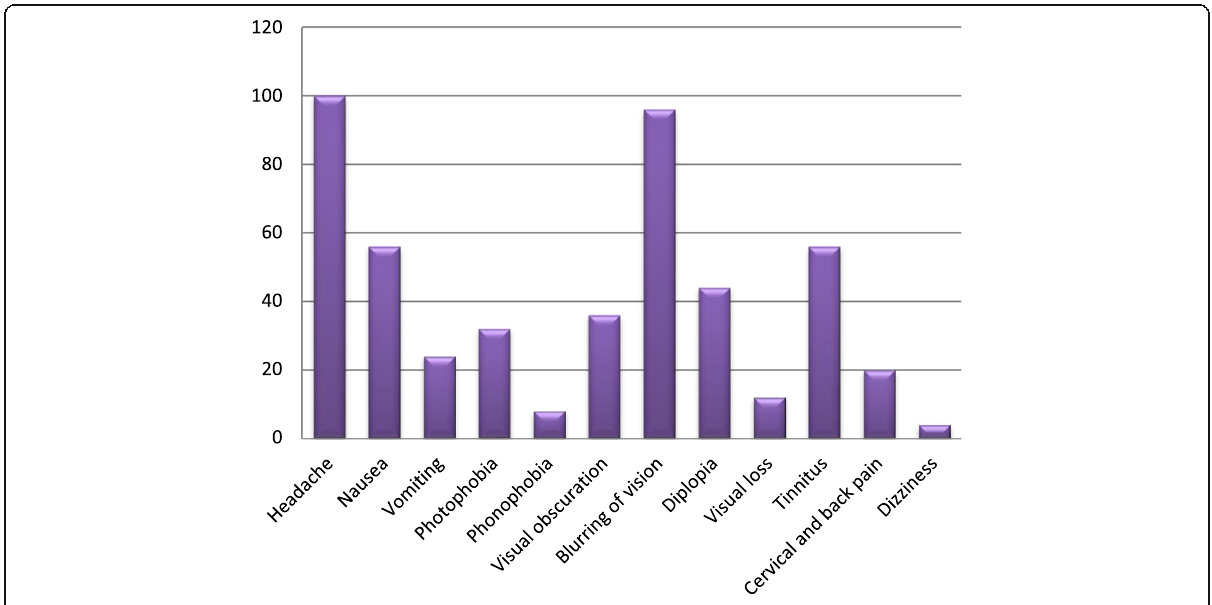
Fig. 1 Distribution of patients according to symptoms ( n = 25)